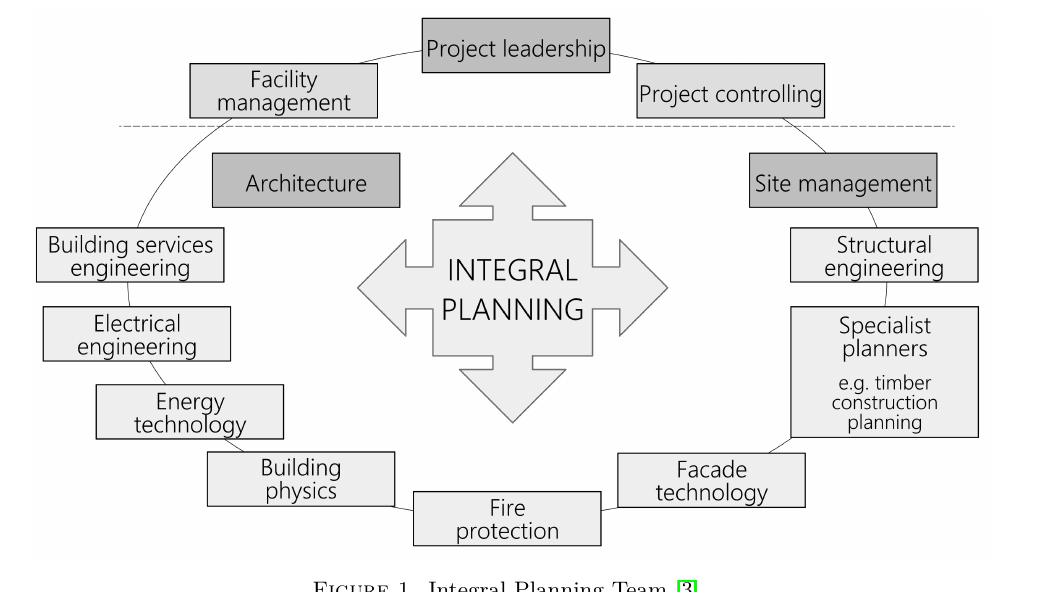
Figure 1. Integral Planning Team [3].